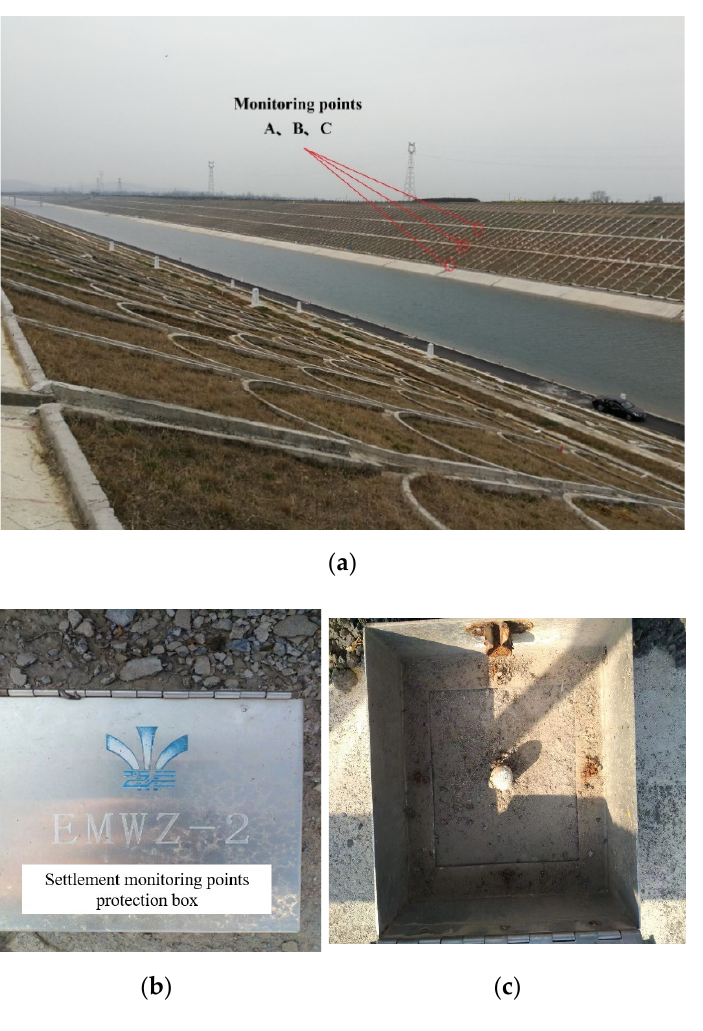
Figure 6. Canal of the South-to-North Water Diversion Project and settlement monitoring points. ( a ) A section of the South-to-North Water Diversion Project, ( b ) Settlement monitoring points protec- tion box, ( c ) Settlement monitoring points.